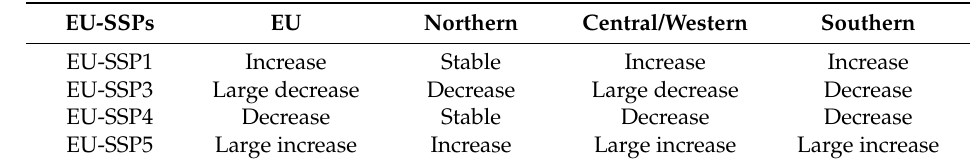
Table 5. Trends in future proportion of elderly living alone in Europe under each European SSP (EU-SSPs), at the European level (EU) and for each of the three countries’